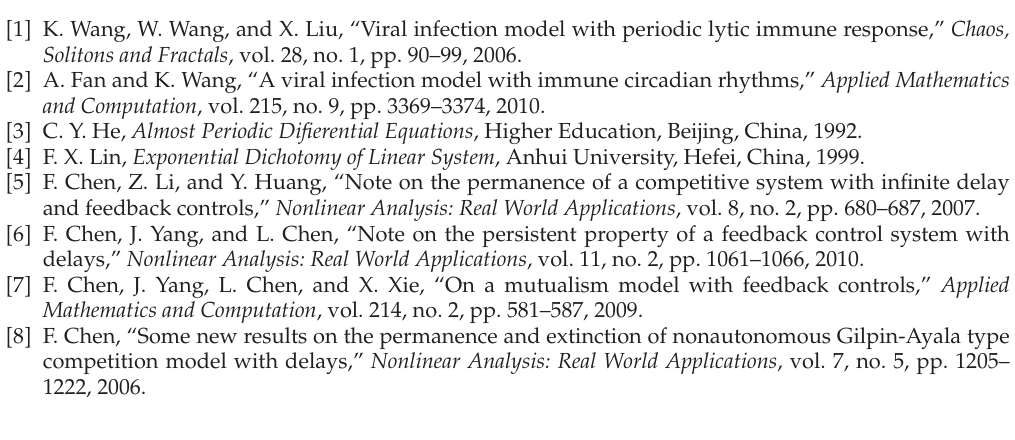
is general nonautonomous continuous function, Theorem A could not be applied to system (cid:3) 3.1 (cid:4)